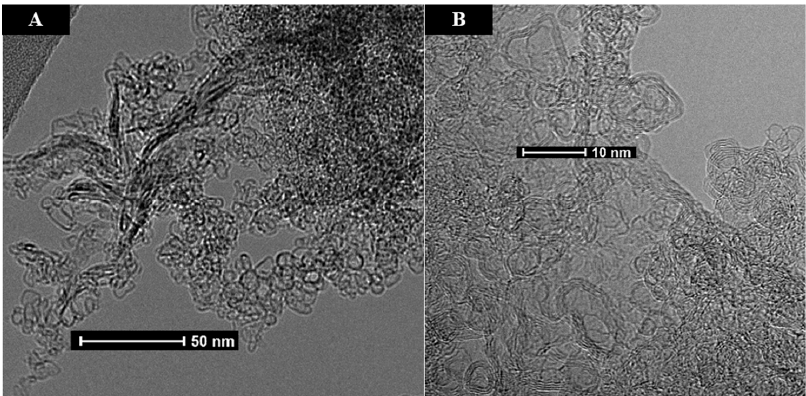
Figure A11. TEM micrographs of anthracene coke—10 pulse—50 mJ/cm 2